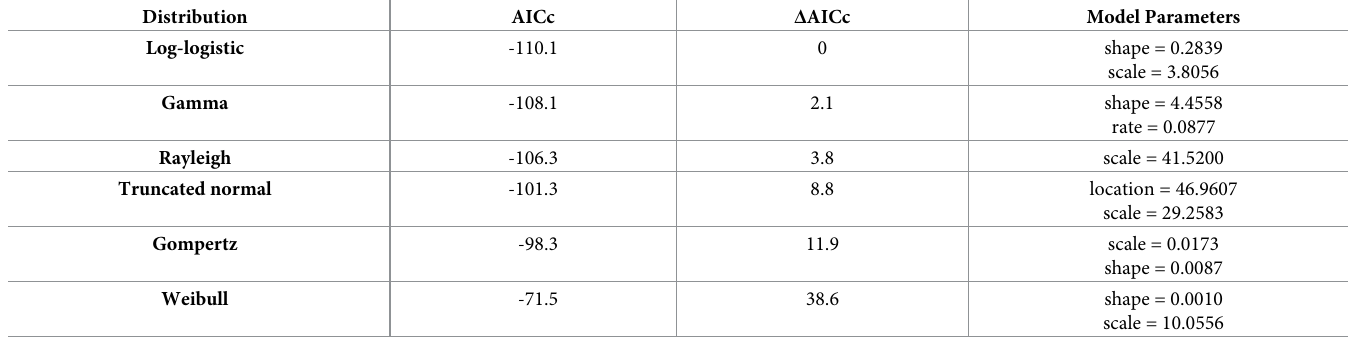
Table 7. Tested carcass density distribution models with corrected Akaike’s information criterion (AICc) and delta ( Δ ) AICc, and fitted parameters.